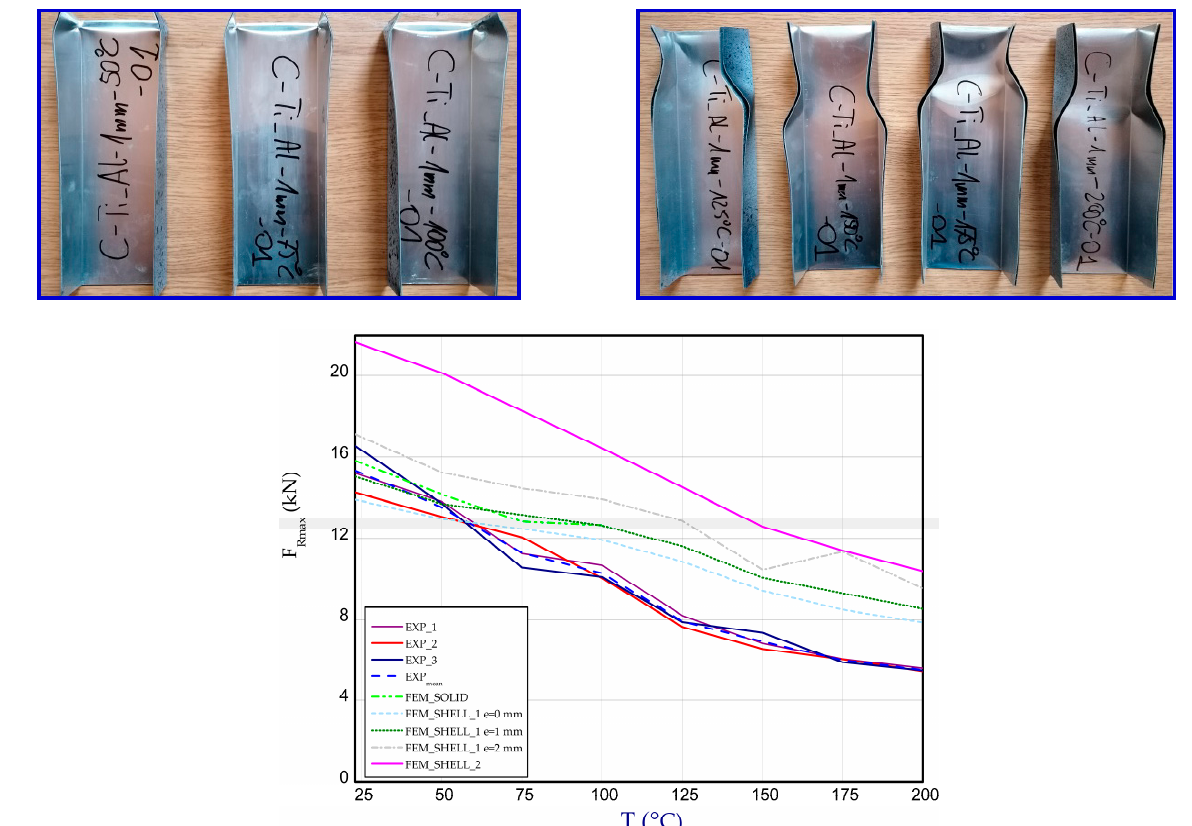
Figure 26. Peaks of loads for all cases with pictures of damaged columns after test (from the left side to the right side for 50 °C, 75 °C, 100 °C, 125 °C, 150 °C, 175 °C, 200 °C, respectively).